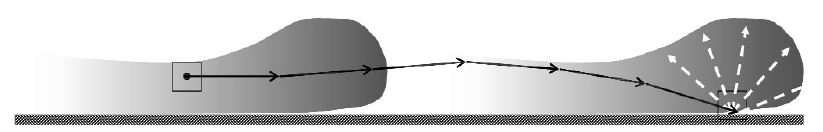
Fig. 3. Assessment of the stagnation pressure in the basal layer of the head of a pyroclastic density current. Sol- id line: trajectory of a flow element brought to rest as the front is shifted; dashed line: cross-flow of air driven by the stagnation